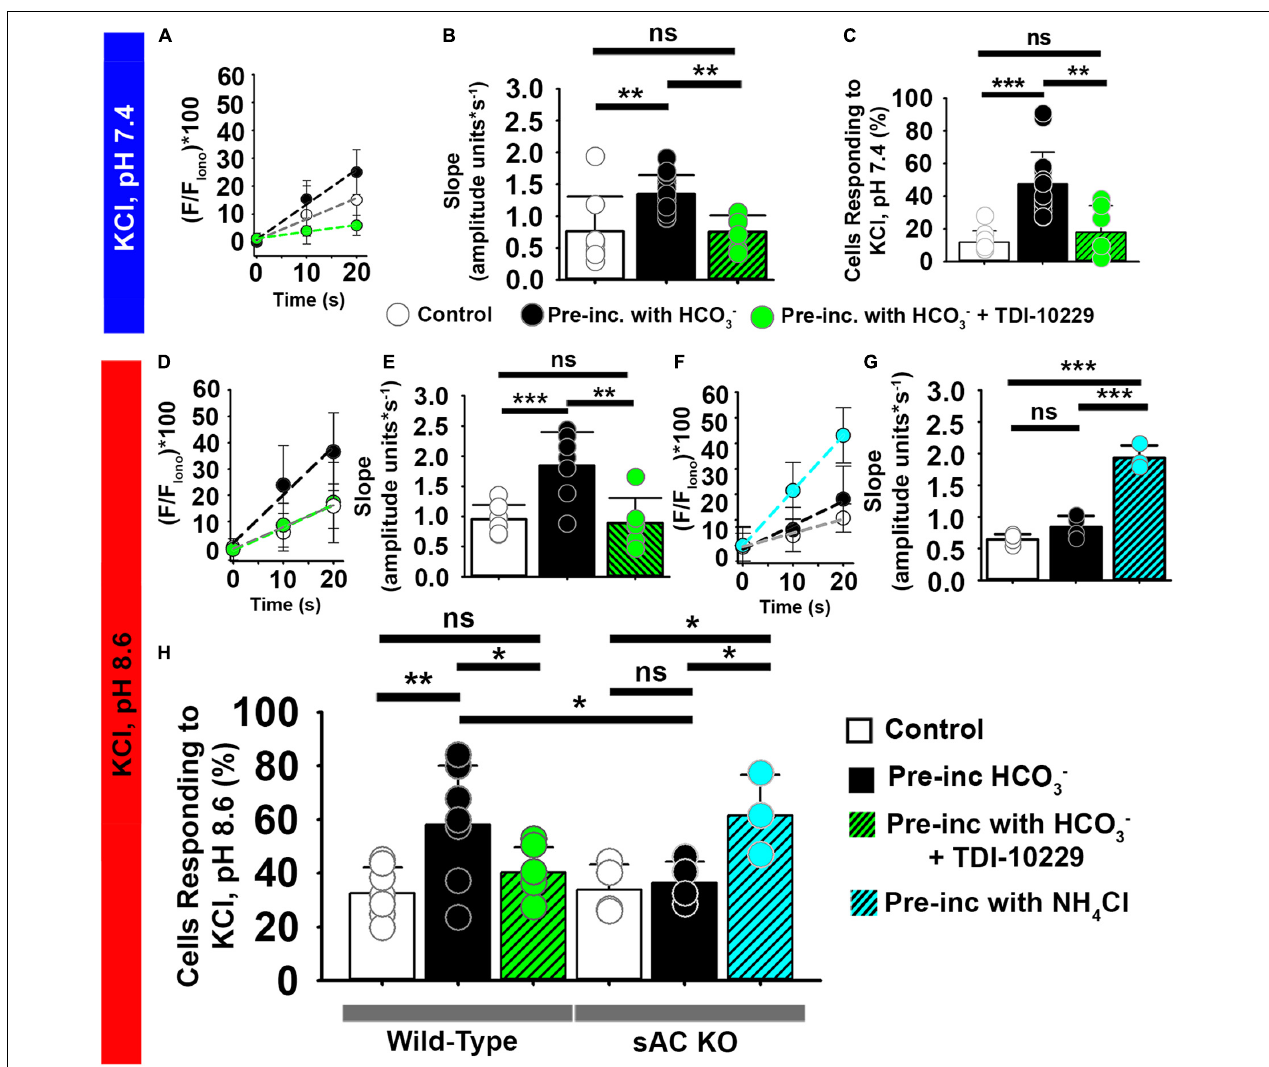
FIGURE 7 | The soluble adenylyl cyclase (sAC) is required for [Ca 2 + ] i increases evoked by KCl after HCO 3 − sensitization in epididymal mouse sperm. (A,D,F) Linear fit of the averaged normalized fluorescence in the first 20 s after KCl addition at (A) pH 7.4 and (D,F) pH 8.6. Data were obtained from epididymal (A,D) wild-type mouse sperm and from (G) sAC KO mouse sperm in control conditions (white) and after pre-incubation with HCO 3 − (black), HCO 3 − + PKA inhibitor TDI-10229 (Green), or NH 4 Cl (Blue). (B) Graph of slope values of the best-fit regression line for each condition. Mean values at pH 7.4 were as follows: control, 0.76 ± 0.547 amplitude units * s − 1 (8 mice, 307 sperm); incubation with HCO 3 − , 1.35 ± 0.297 amplitude units *s − 1 (15 mice, 1035 sperm); and incubation with TDI-10229, 0.75 ± 0.259 amplitude units *s − 1 (6 mice, 364 sperm). (C) Graph of the percentage of responsive sperm. Mean values at pH 7.4 were as follows: control, 11.80% ± 6.9 (8 mice, 307 sperm); HCO 3 − , 47.6% ± 19.39 (15 mice, 1035 sperm); and HCO 3 − + TDI-10229,17.8% ± 16.33 (6 mice, 364 sperm). (E) Slope values per animal of the best-fit linear regression of the rise in KCl at pH 8.6 in different conditions. Mean values at pH 8.6 were as follows: control, 0.95 ± 0.237 amplitude units * s − 1 (7 mice, 243 sperm); HCO 3 − , 1.84 ± 0.556 amplitude units *s − 1 (7 mice, 281 sperm); and HCO 3 − + TDI-10229, 0.88 ± 0.413 amplitude units *s − 1 (6 mice, 126 sperm). (G) Graph of slope values of the best-fit regression line for each condition in the sAC KO mice. Mean values at pH 8.6 were as follows: control, 0.645 ± 0.084 amplitude units * s − 1 (4 mice, 123 sperm); HCO 3 − , 0.840 ± 0.173 amplitude units *s − 1 (4 mice, 109 sperm); and NH 4 Cl, 1.932 ± 0.197 amplitude units *s − 1 (3 mice, 74 sperm). (H) Graph of the percentage of responsive sperm. Mean values for wild-type at pH 8.6 were as follows: control, 32.62% ± 9.58 (7 mice, 243 sperm); HCO 3 − , 58.05% ± 21.94 (7 mice, 281 sperm); and HCO 3 − + TDI-10229, 40.25% ± 9.51 (6 mice, 126 sperm). Mean values for sAC knockout at pH 8.6 were as follows: control, 33.80% ± 9.44 (4 mice, 91 sperm); HCO 3 − , 36.36% ± 7.96 (4 mice, 83 sperm); and NH 4 Cl, 61.47% ± 15.20 (3 mice, 74 sperm). * P < 0.050, ** P < 0.010, *** P < 0.001, and ns, non-significant by one-way ANOVA. Error bars indicate standard deviation. Iono = 5 µ M Ionomycin + 2 mM Ca 2 +